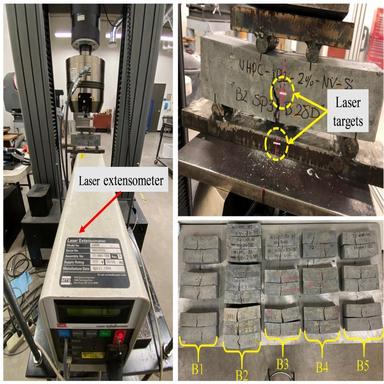
Flexural testing and instrumentation of the NP-UHPC prisms.